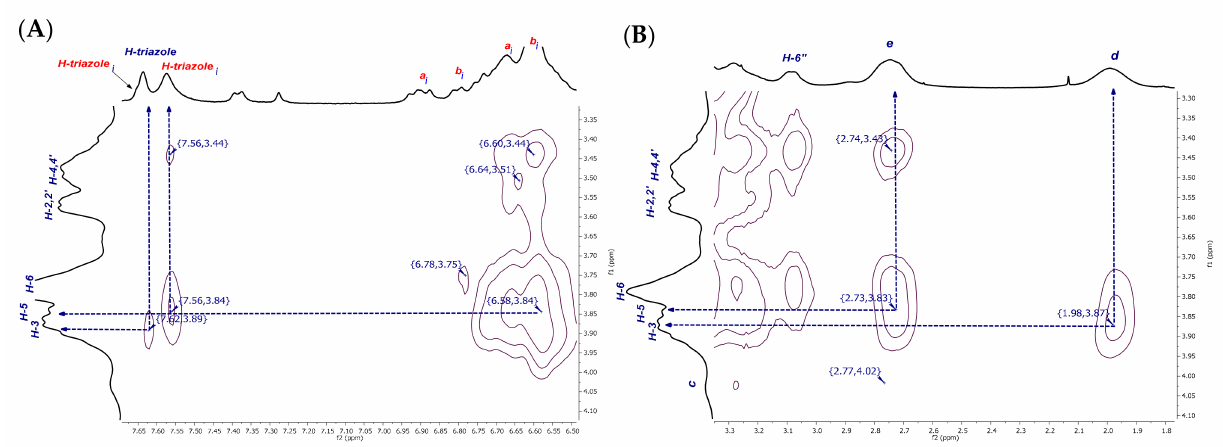
Figure 7. Amplification of ( A ) aromatic and ( B ) aliphatic zones in 2D NMR NOESY spectrum of P 3 N 3 -[O-C 6 H 4 -O-(CH 2 ) 3 - β CD] 6 ( I ) in D 2 O.